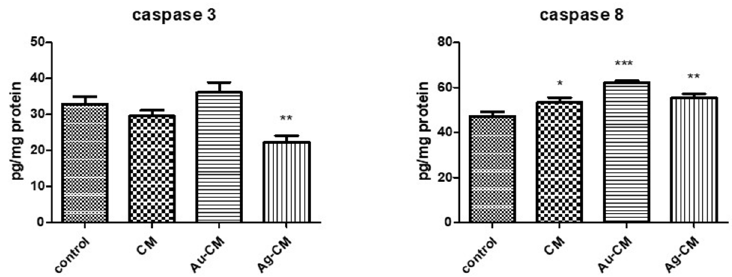
p < 0.01 for Ag-CM) (Figure 11).